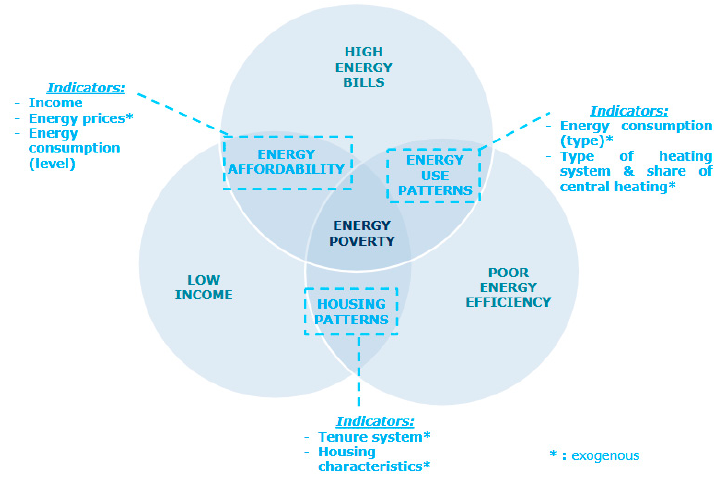
Figure 1. Energy poverty triad. Source: Pye et al. [11].